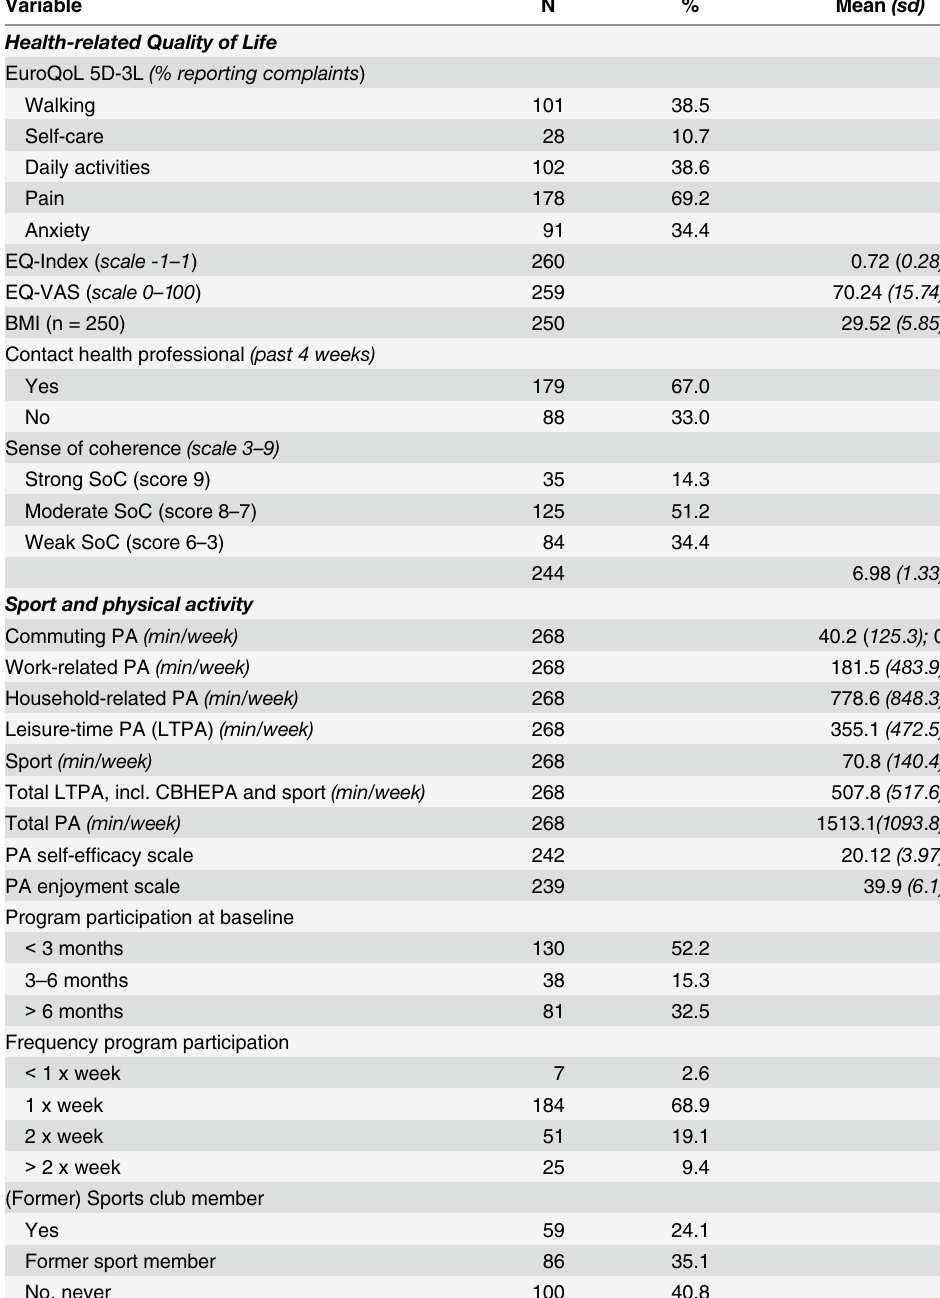
Table 4. Baseline health-related and PA outcomes for